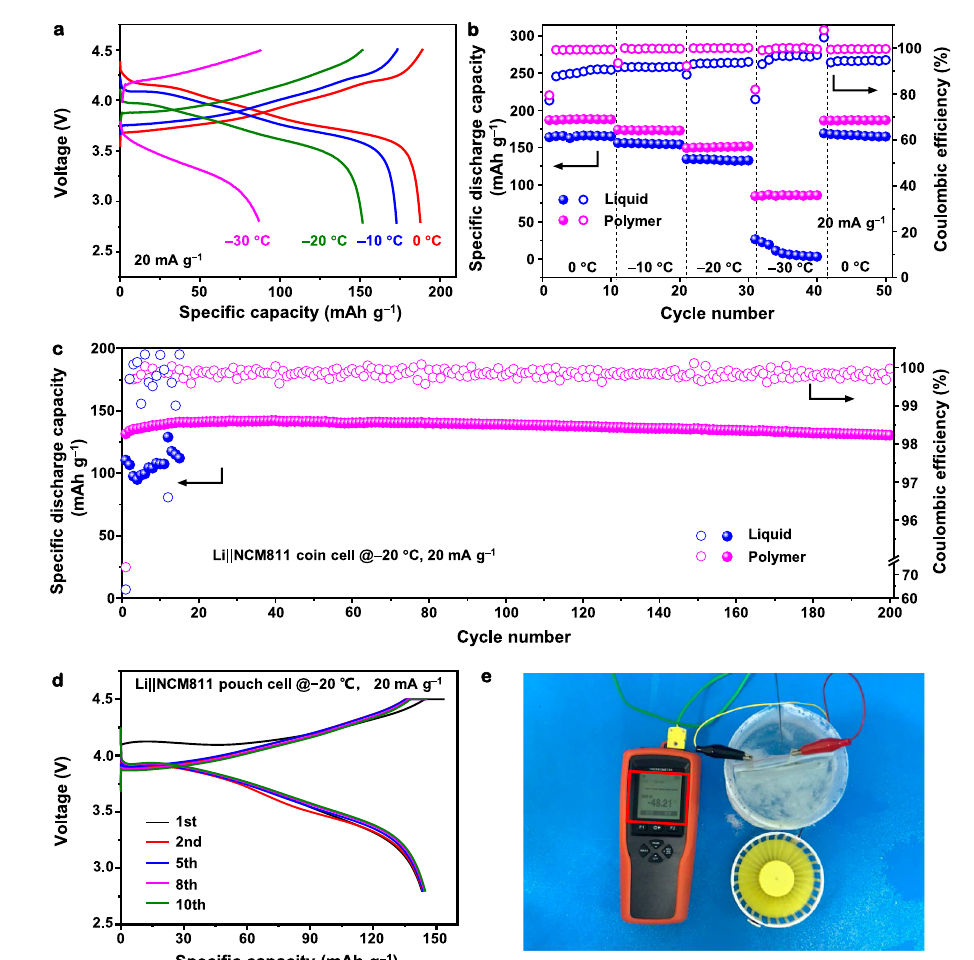
Fig. 3 | Electrochemical energy storage performances of Li||NCM811 cells with polymer or liquid electrolytes cycled at various temperatures. a Charge- discharge voltage pro fi les (the second cycle at each temperature, 2.8 – 4.5V) of the designed polymer electrolyte in the Li||NCM811 coin cell at different temperatures and 20mAg − 1 . b Discharge capacities with CEs of both electrolytes in Li||NCM811 coin cells atdifferent temperatures and 20mAg − 1 . c Cycling performances of both electrolytes in Li||NCM811 coin cells at − 20°C and 20mAg − 1 . d Charge – discharge